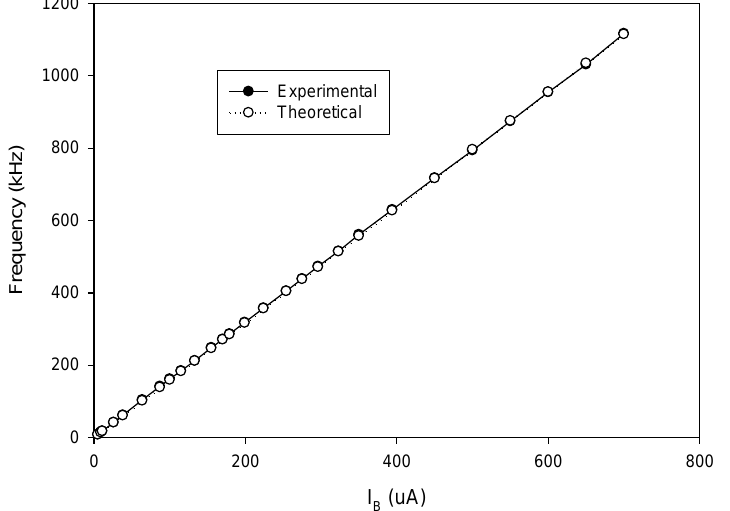
op1 and ( b ) v op2 .